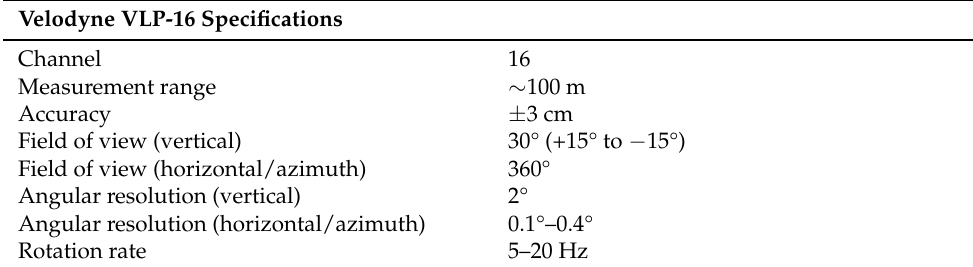
Table 2. LiDAR specifications.